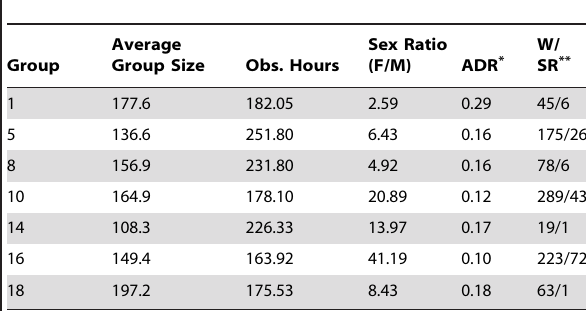
Table 1. Attributes of rhesus groups observed in